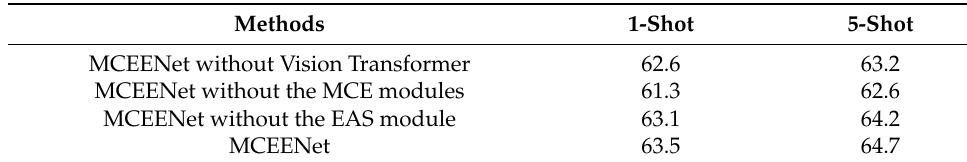
Table 2. Ablation study on Vision Transformer, the MCE module, and the EAS module in terms of mIoU.